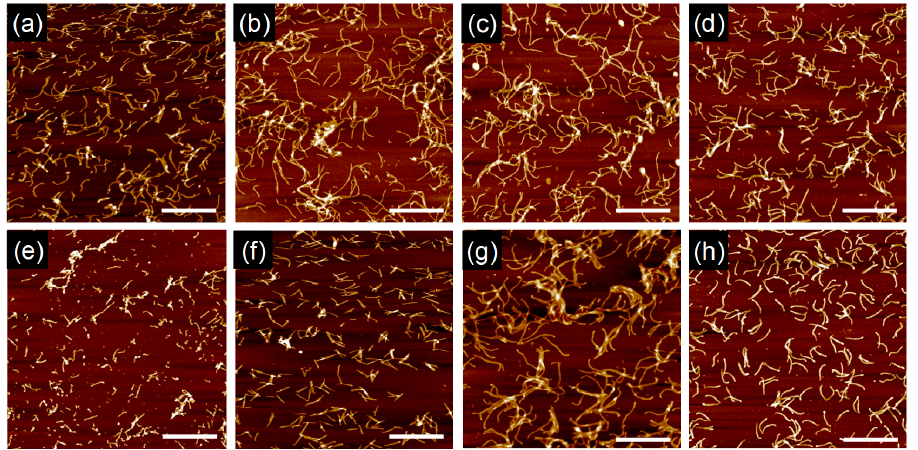
Figure 11. AFM topographic images of nanowires from dropcast films of ( a ) SBF , ( b ) 2Br-SBF , ( c ) 4Br-SBF , ( d ) 2,2 ′ Br 2 -SBF , ( e ) 2,7Br 2 -SBF , ( f ) Br 4 -SBF , ( g ) SBF 2 , and ( h ) SBF 3 . The films were irradiated by 350 MeV 129 Xe 26+ particles at a fluence of 1.0 × 10 10 cm − 2 and developed by toluene at room temperature. Scale bars represent 500 nm. Reproduced with permission from ref. [114] ©2019, American Chemical Society.